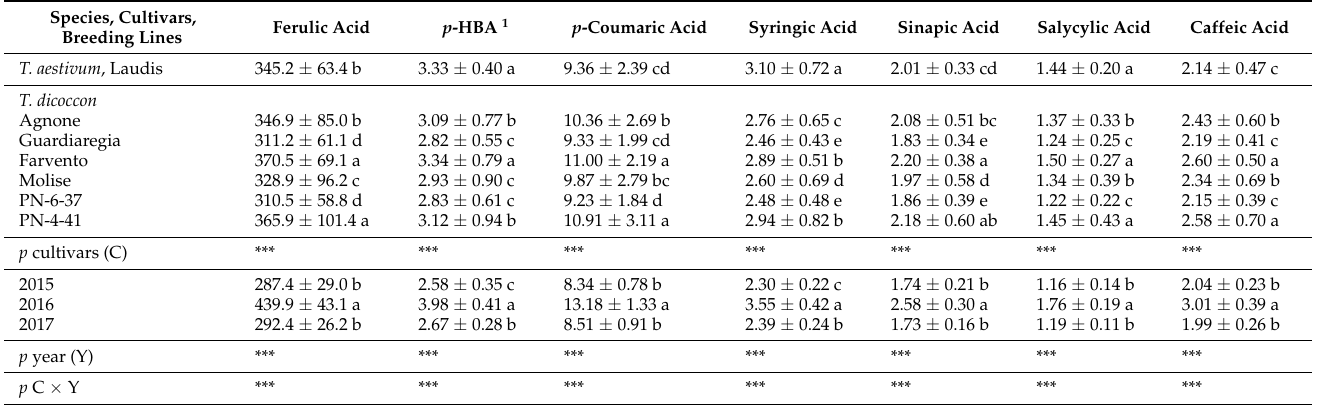
Table 5. Effect of wheat cultivars and growing years on bound individual phenolic acids concentra- tions ( µ g g − 1 DM) in whole-grain